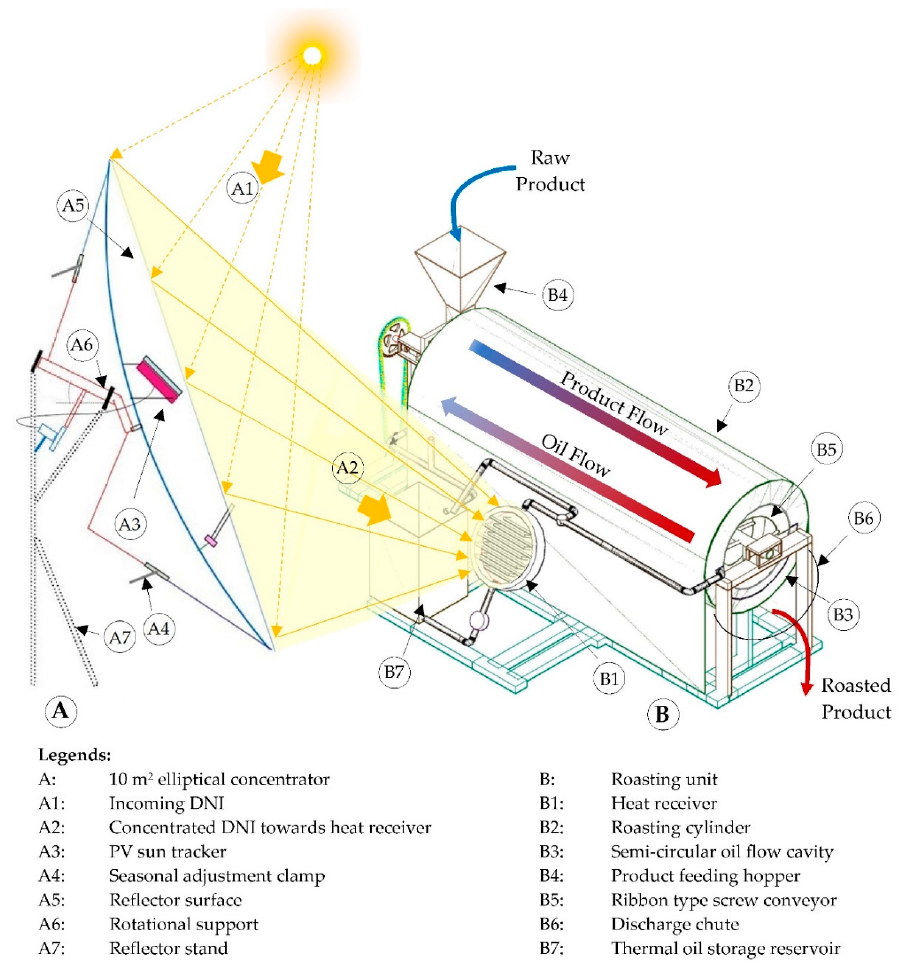
Figure 1. Schematic of Continuous Solar Roaster (CSR).